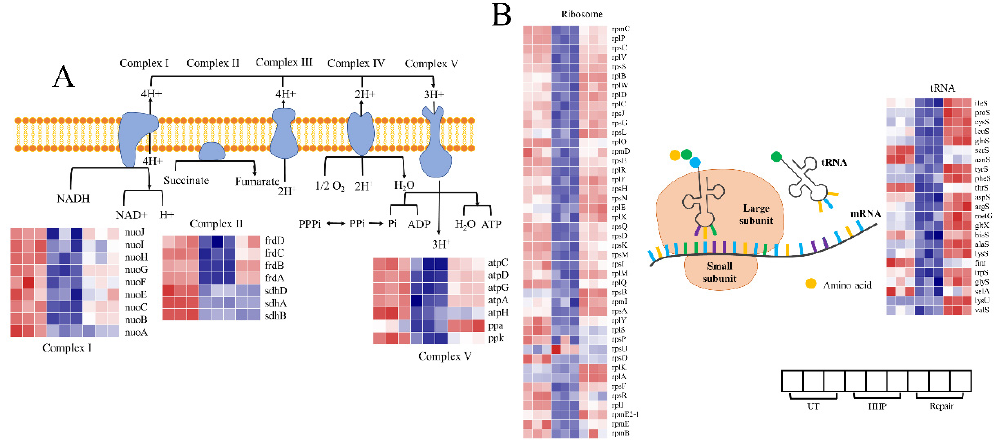
Figure 6. Transcriptional changes of genes involved in the significantly enriched pathway. ( A ) The oxidative phosphorylation pathway. ( B ) The ribosome and aminoacyl-tRNA biosynthesis path- ways.